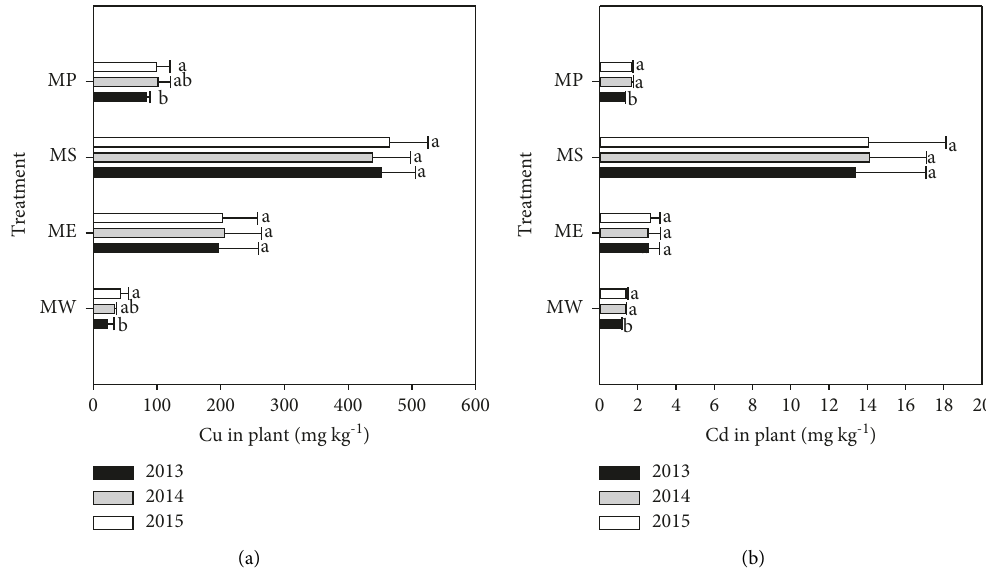
Figure 3: Concentrations of (a) Cu and (b) Cd in the shoots of each plant. MW � Setaria lutescens, ME � Elsholtzia splendens, MS � Sedum plumbizincicola, MP � Pennisetum sp. Different lowercase letters indicate significant differences in the same treatment during the three years ( n � 3, P < 0 . 05).